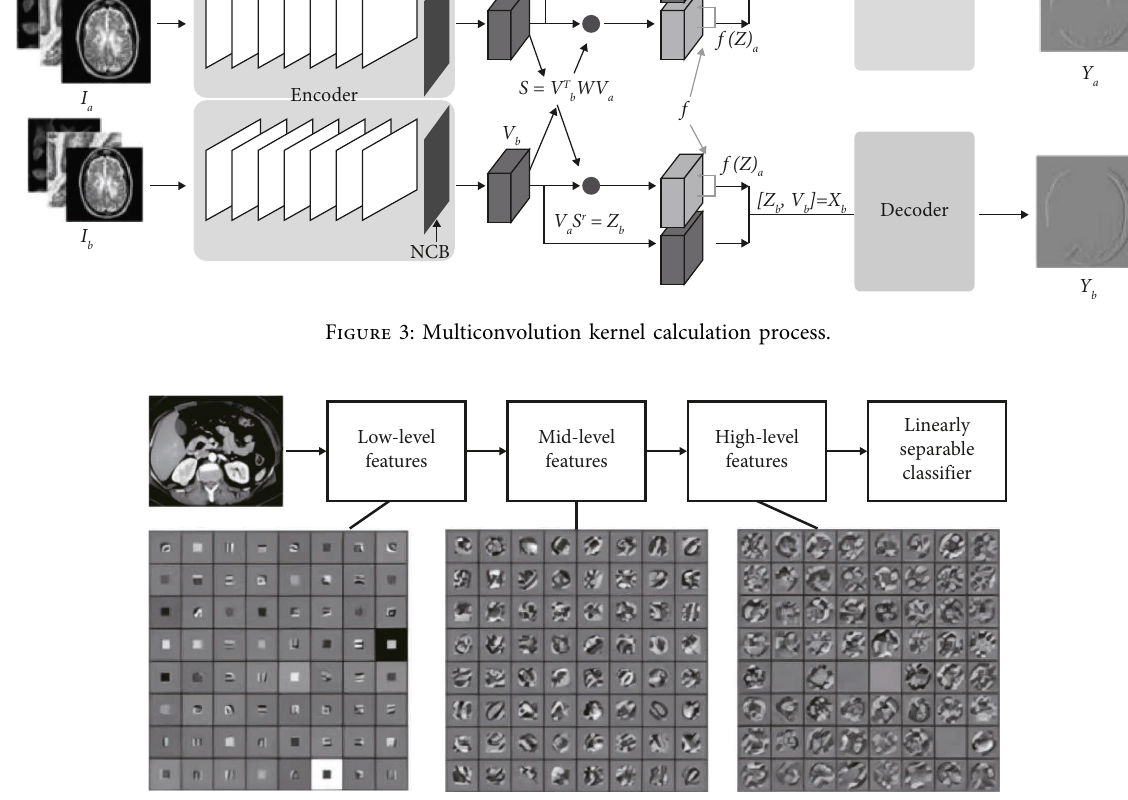
Figure 4: Analysis of biological image recognition